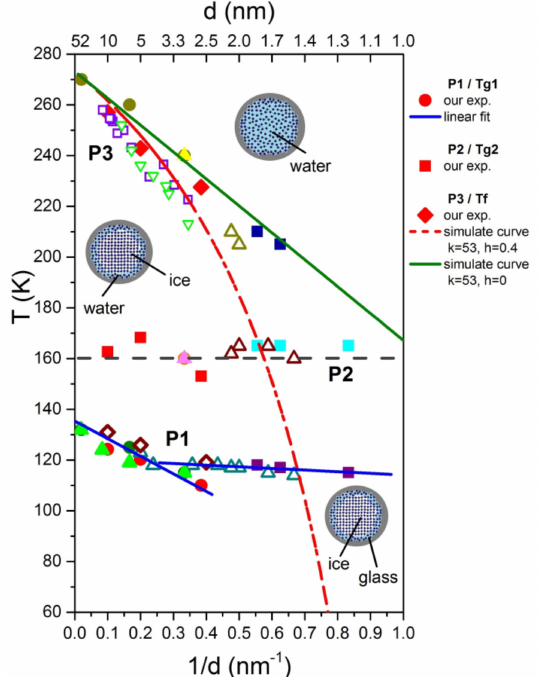
Figure 6. Pore size dependencies of the processes P1, P2 and P3 from DMA measurements (red symbols) and adiabatic calorimetric data [13,33]. Reproduced from the data of Figure 6 from Ref. [31], where all symbols are explained in detail. P3 = melting line, P1 = glass transition, P2 = due to re-orientational motion of water molecules attached to pore surface by hydrogen bonding [31]. The red dot-dashed line is calculated using [27] T m (d) = T mbulk – K GT / (d / 2-h), with K GT = 53 Knm and h = 0.4 nm. The green line is calculated with h =